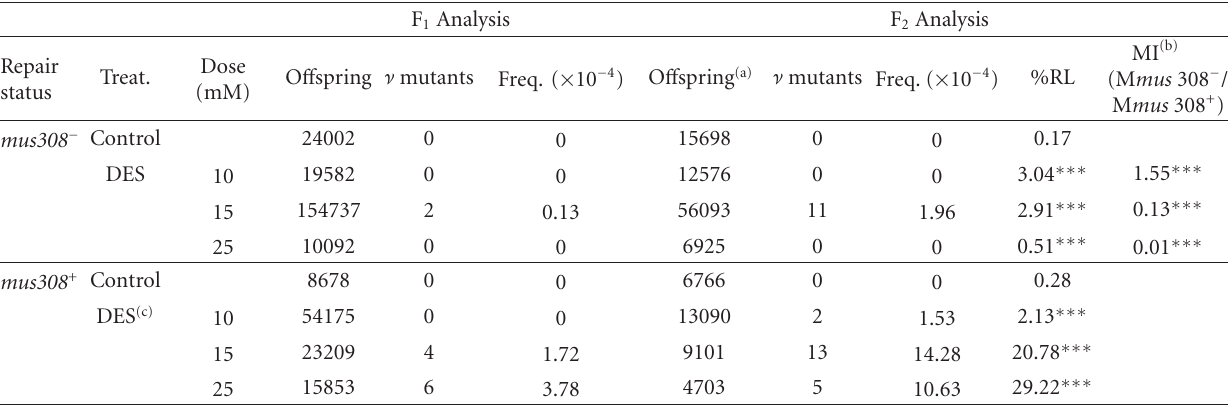
Table 1: Recessive lethal (RL) and v mutation frequencies induced by DES on postmeiotic male germ cells of D. melanogaster , under mus308 deficient ( mus 308 − ) and e ffi cient ( mus 308 + ) conditions. Values of mutability index (MI) and their statistical signification are also presented.